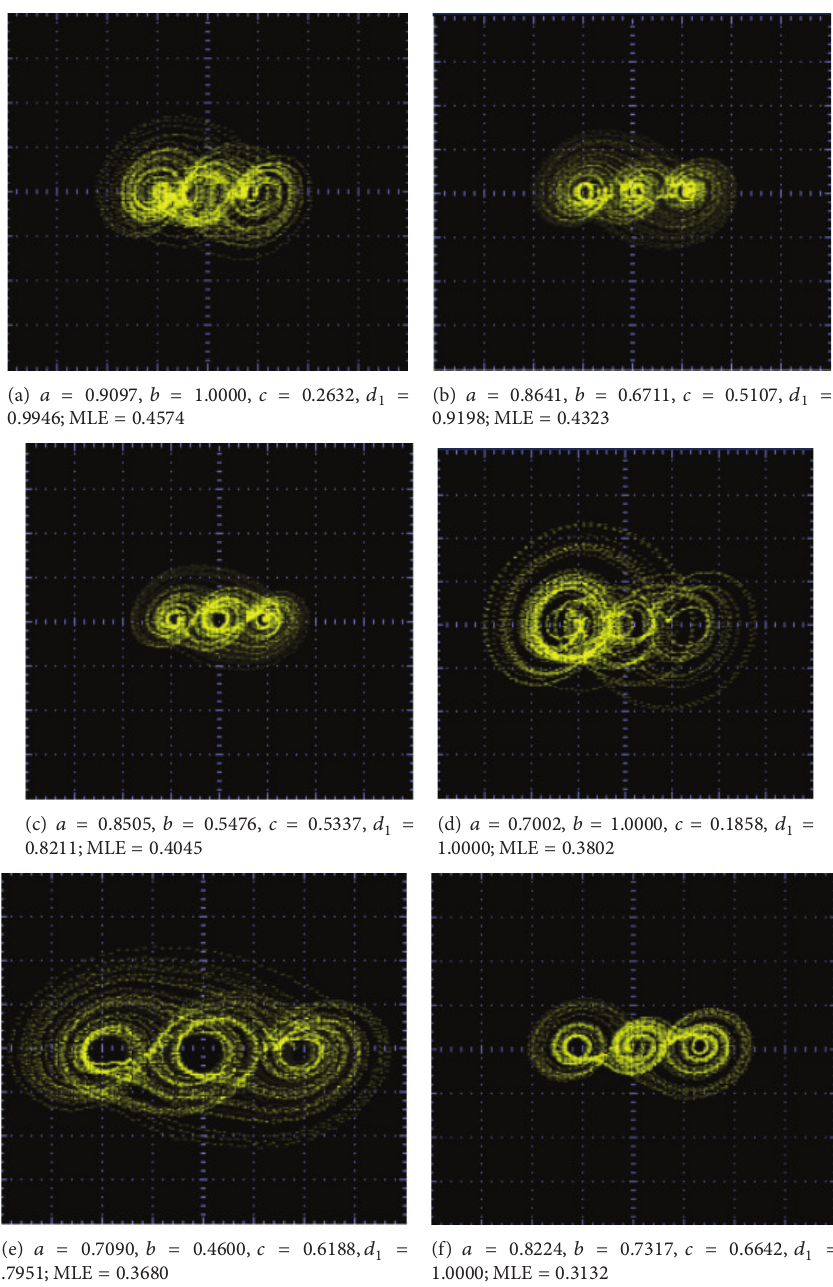
Figure 10: Optimized MLE for generating 3